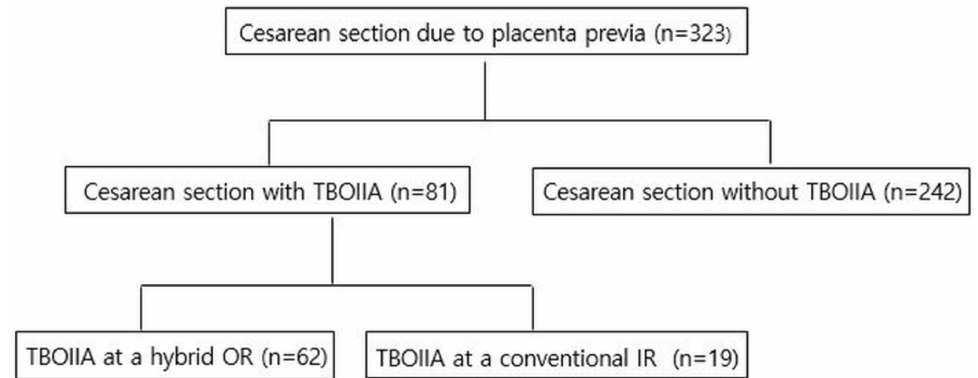
Figure 1. Distribution of patients with placental abnormality who underwent cesarean delivery during the study period. TBOIIA, temporary transcatheter balloon occlusion of bilateral internal iliac arteries; OR, operating room; IR, interventional